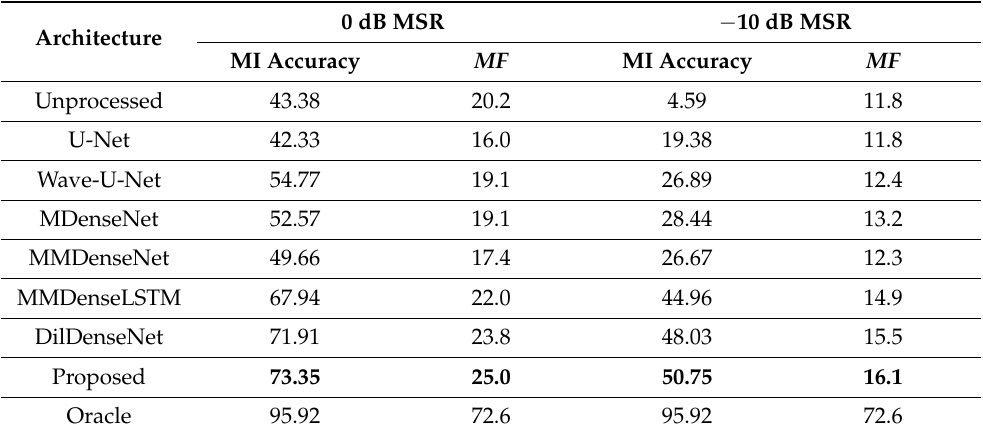
Table 8. MI accuracy (%) and the average number of matched fingerprints ( MF ) in the identified